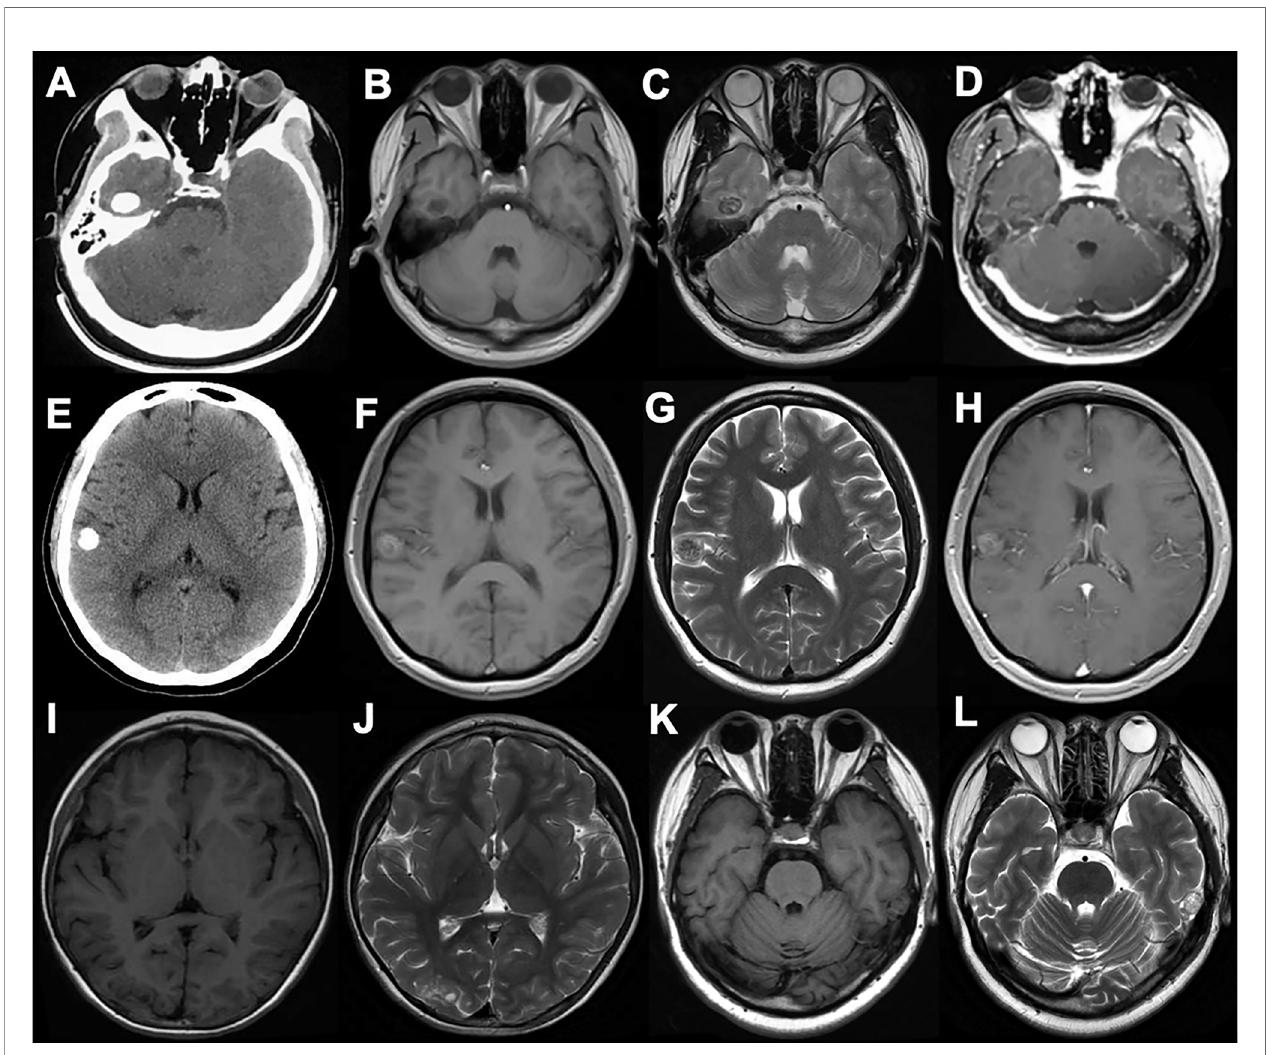
FIGURE 1 | The CT, MRI manifestation of PLNTY. Dense calci fi cations were often demonstrated in CT images (A, E) . The MRI scans often appeared as iso- or low signal in T1W1 (B, I, K), and also can be slight hyperintense because of the composition of calcium salts (F) . The increased or mixed-signal were seen in T2W2 (C, G, J, L) , and the cystic components were also seen in (J, L) . No enhancements were shown in post-gadolinium T1-weighted MR images (D, H)